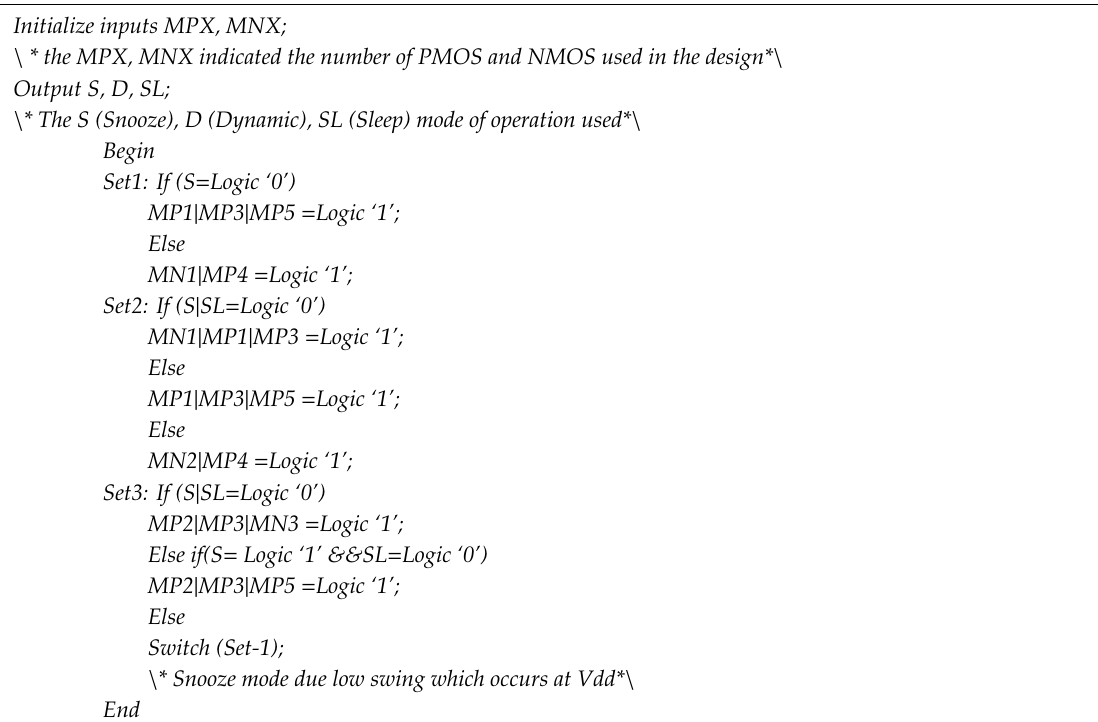
Algorithm 1. Deep learning-assisted IoT System Routing Mode-I Operation for data